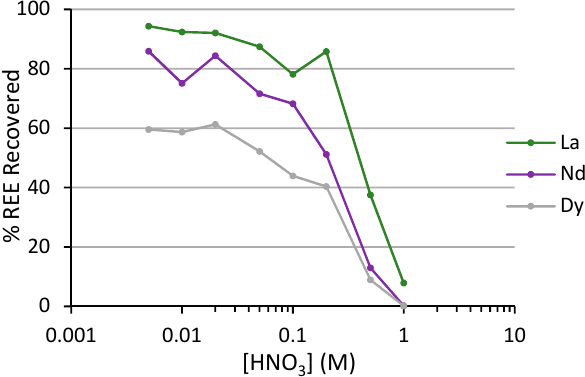
Figure 2. The extraction of La, Nd and Dy (0.01 M) in using IL (0.1 M) with varying HNO 3 (0.005–1.0 M) at constant NO 3 − concentration (7 M). Interpolation used to aid the eye only.